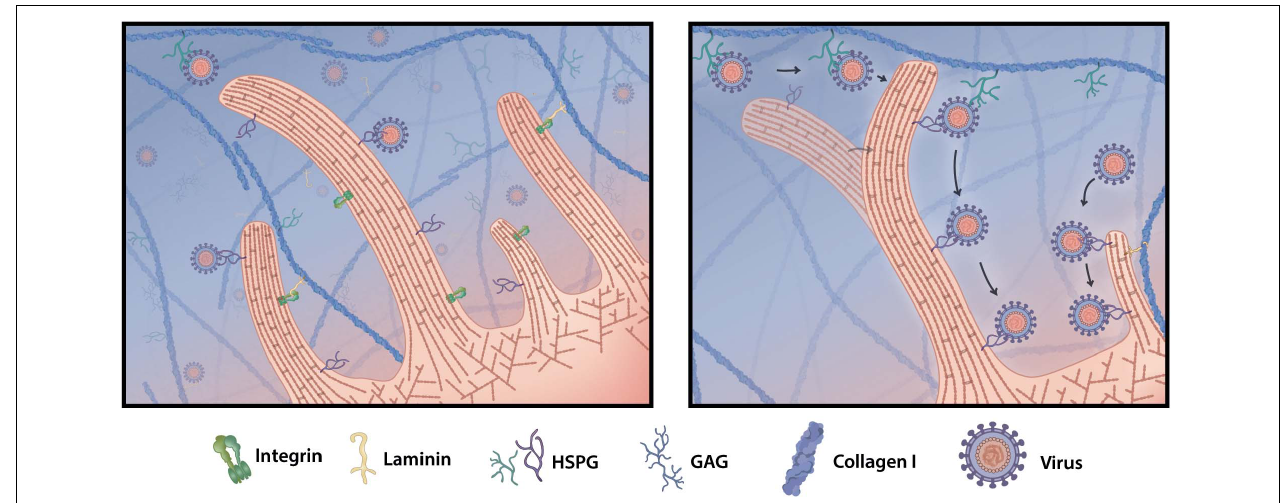
FIGURE 6 | Filopodia grab virus particles off the matrix. Viruses that enter tissues stick to ECM proteins, such as HSPG, or freely diffuse in the interstitial fluid. Upon cell infection some viruses modify the cellular cytoskeleton and are able to induce cell protrusions called filopodia. When filopodia explore and interact with components of the ECM, they encounter freely floating or HSPG-bound virus particles and pick them off the matrix. Viruses hop from matrix HSPG onto secondary cell membrane HSPG and can surf along the filopodia shaft toward the cell body, where they invade and infect the target